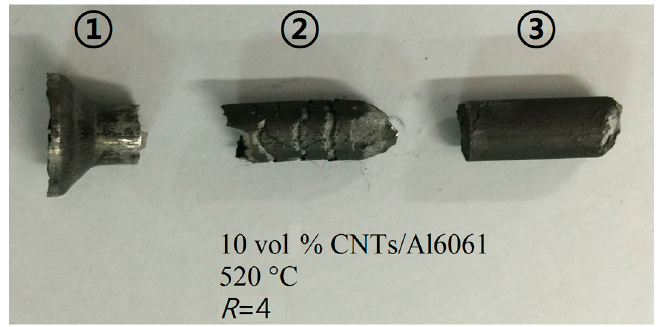
Figure 10. Physical figure of the fracture surface of extrusion part.